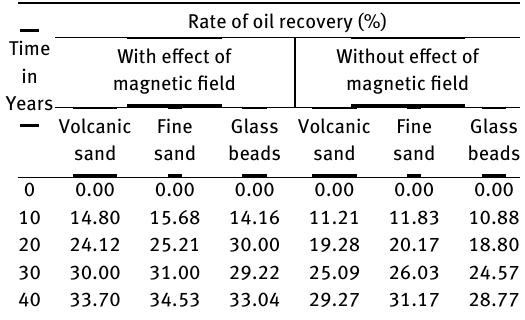
Table 7: Numerical values of recovery rate in various types of porous matrix